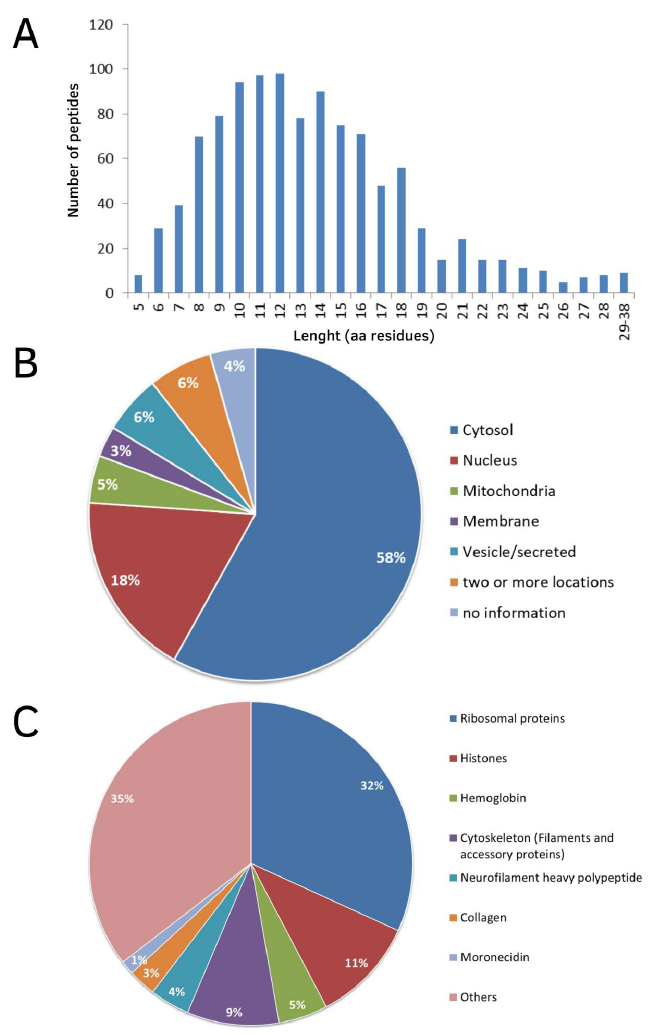
Figure 1. General features of peptide sequences found in gills of seahorse H. reidi . In ( A ), peptide distribution by length (amino acid residues). In ( B ), subcellular location of precursor proteins of peptides. In ( C ), classes of precursor